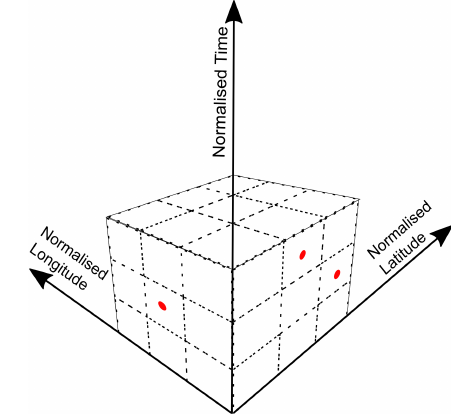
Figure 6. Space–time cube as used in the SI–CH (spatiotemporal identification of compound hazards) methodology proposed in this paper. The three small red dots represent extreme values. Each cube is for a normalised latitude × normalised longitude × normalised time period. Each side of the cube is 1.0 and unitless, with nor- malisation factors for latitude and longitude a (in units of ◦− 1 ) as well as a normalisation factor for time b (h − 1 ). Normalised latitude and longitude for our ERA5 data are ( a × 0 . 25 ◦ ), with a = 4 ◦− 1 , and normalised time is ( b × 1h), with b = 1h − 1